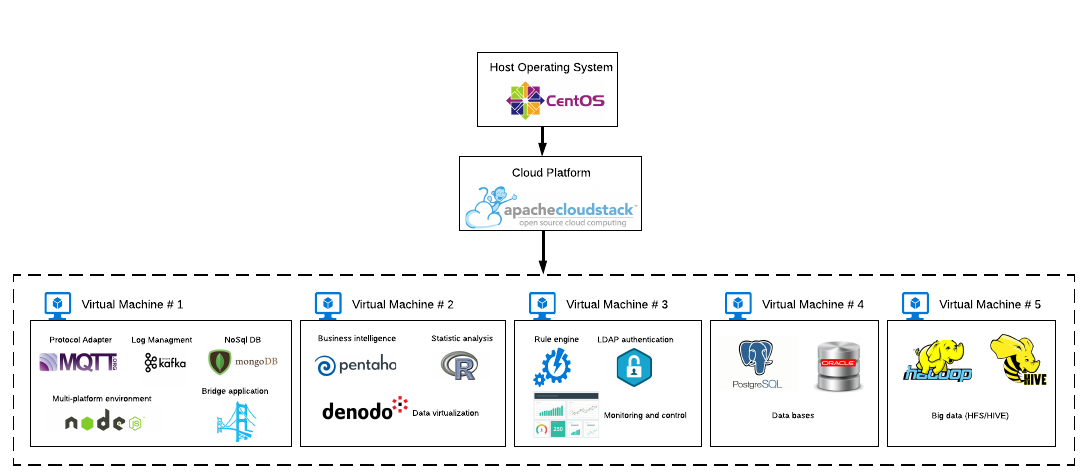
Figure 14. The IotM@ch cloud